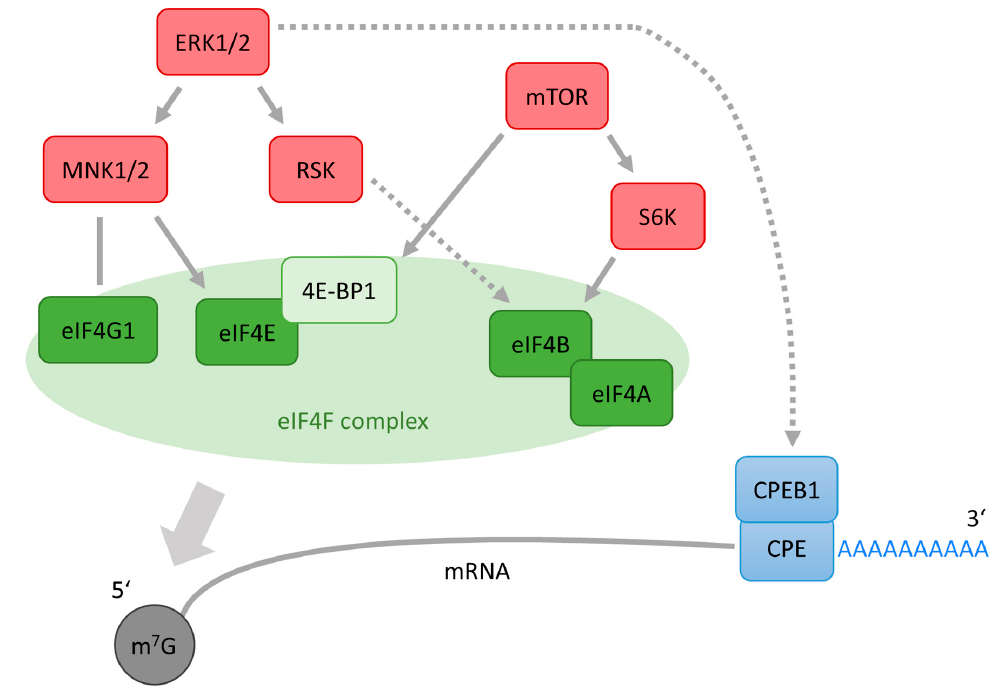
Figure 6. ERK1/2 and mTOR regulate protein translation in oocytes. MAPK-interacting kinase (MNK1), a downstream target of ERK1/2 stabilizes the binding of eIF4E to the m7G cap by phosphorylation eIF4E at the Ser209 residue. The eIF4E phosphorylation on Ser209 is considerably enhanced when MNK1 and MNK2 (MNKs) are bound to eIF4G1. Although downstream members of both ERK1/2 and mTOR pathways phosphorylate eIF4B in somatic cells, involvement of ERK1/2 in eIF4B phosphorylation was not reported in oocytes. In Xenopus oocytes ERK1/2 phosphorylates CPEB1 at four residues but not on Ser174, a key residue for activation of CPEB1. In mouse, a role of ERK1/2 in CPEB1 phosphorylation was confirmed only in cumulus-enclosed oocytes. Factors associated with cap-dependent translation initiation are depicted in green, poly(A) tail factors in blue, and kinases in red. Stimulatory modification is depicted as an arrow, inhibitory modification as a blunt end line. Dashed line with arrow indicates tentative stimulatory